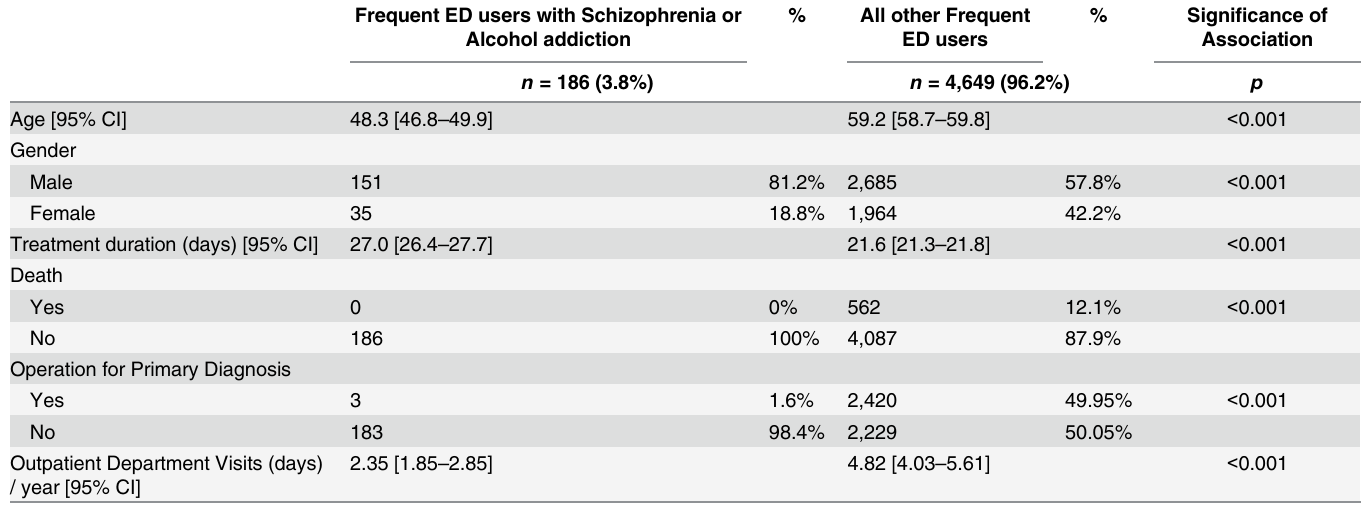
Table 4. Comparison of frequent ED users with schizophrenia or alcohol addiction with all other frequent ED